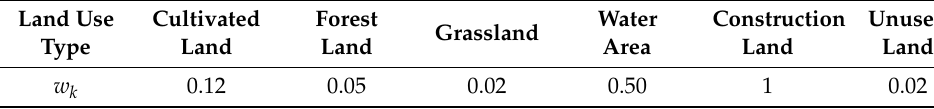
Table 6. Assignment of neighborhood effect parameters.